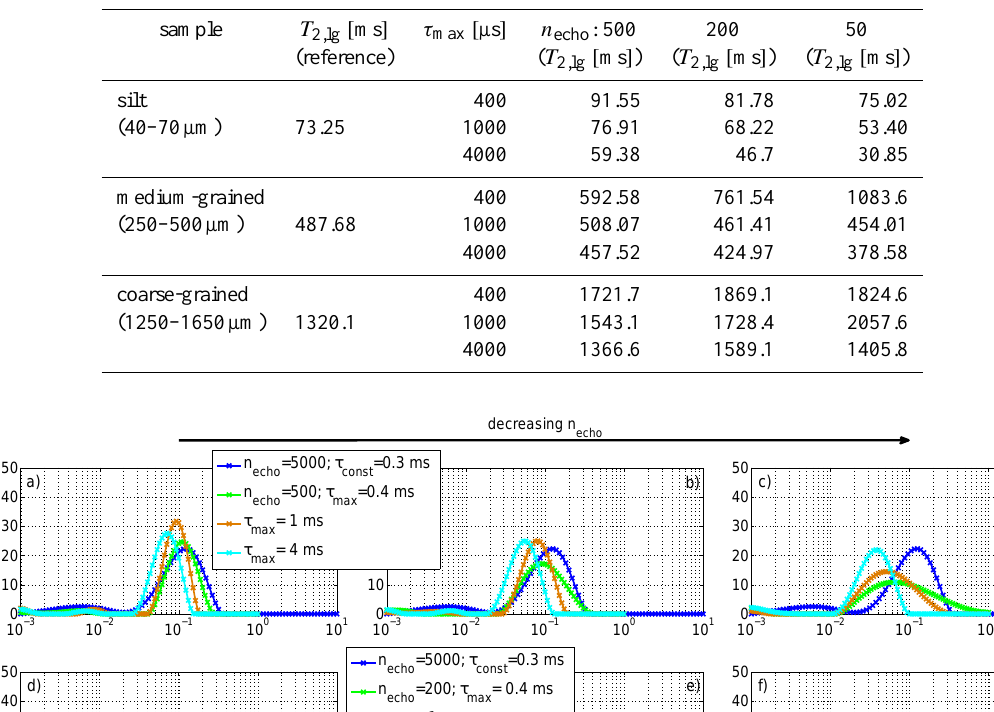
Table 3. Logarithmic mean decay time T 2,lg for all CPMG sequences conducted on glass beads. The second column denotes T 2,lg of the reference sequence conducted with n echo =5000 and a constant τ =300µs.